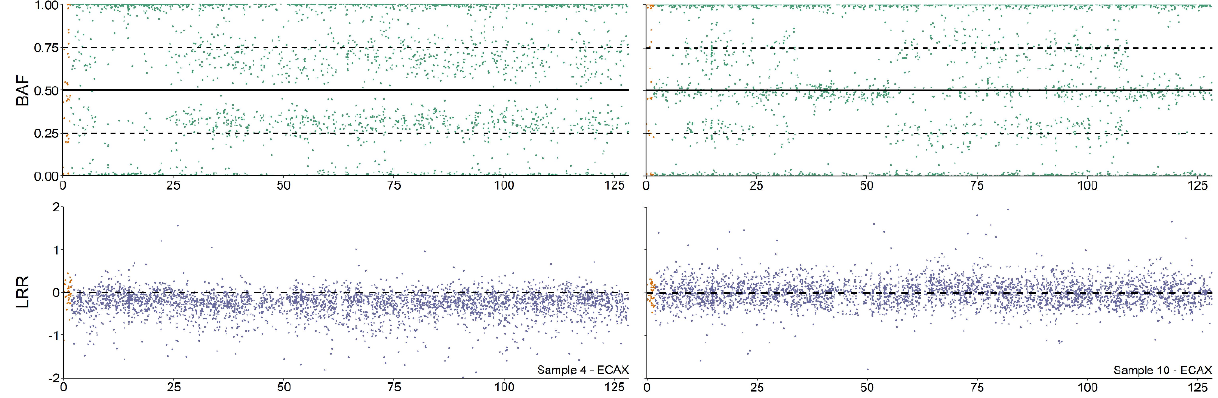
Figure 2. Copy number alterations (CNA) analysis profile of 64,XY/64,XX and 64,XX/64,XX blood chimeras. Analysis of the B allele frequency (BAF) and Log R ratio (LRR) values of the ECAX from 64,XY/64,XX (Sample 4, left part) and 64,XX/64,XX individuals (Sample 10, shown on the right of the figure) according to Pirosanto, et al . [12] .